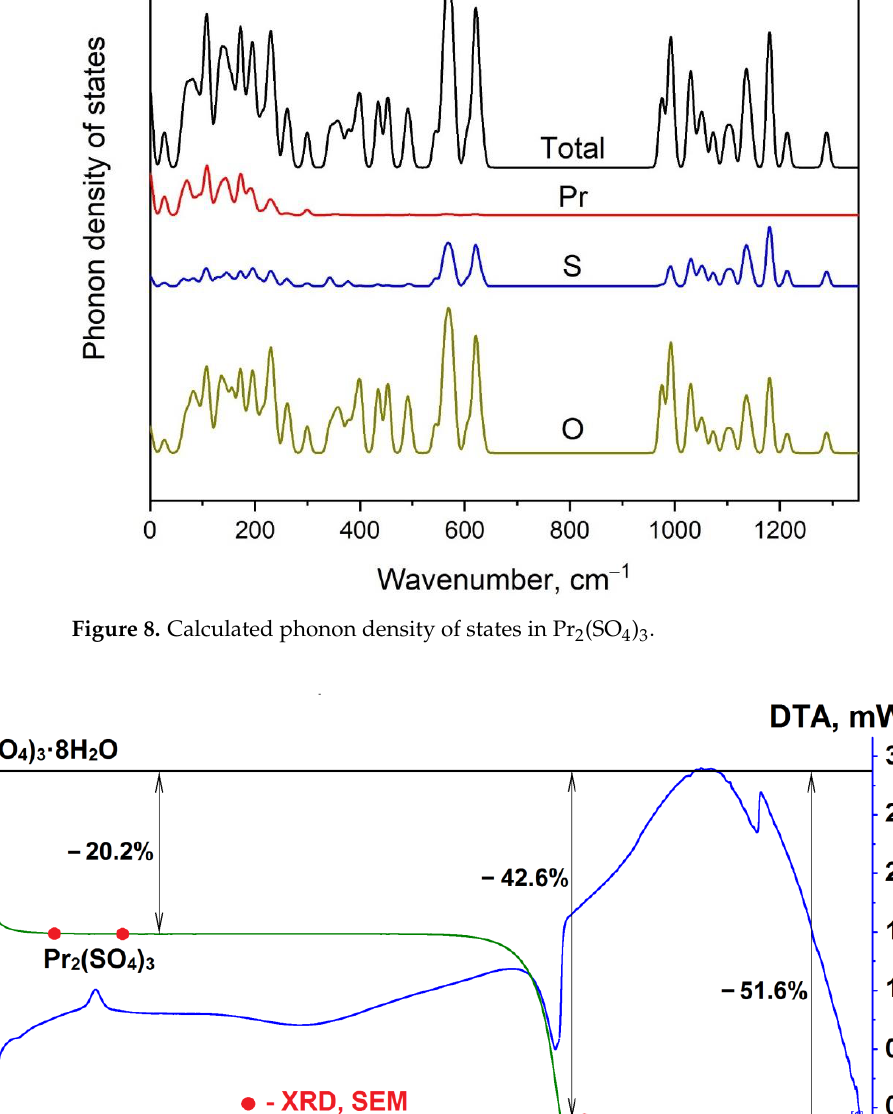
Figure 9. Simultaneous DTA/TG of Pr 2 (SO 4 ) 3